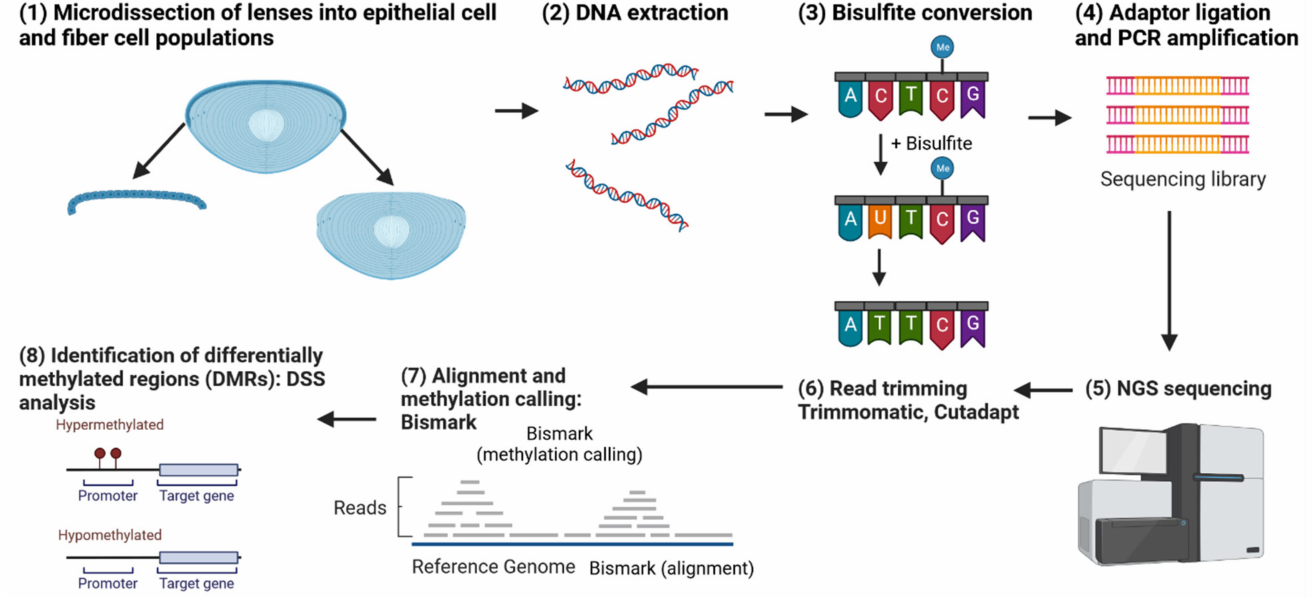
Figure 11. Workflow for a whole-genome bisulfite sequencing (WGBS) experiment comparing lens epithelial cells and fiber cells. The figure outlines the steps from sample preparation, bisulfite conversion, and sequencing to data preprocessing and analysis. The WGBS data are used to identify differentially methylated regions (DMRs) between lens epithelial and fiber cells, providing insights into the role of DNA methylation in lens differentiation. Additionally, the figure highlights the incorporation of transcription factor consensus sequence analysis to uncover potential regulatory the epigenetic mechanisms governing lens cell differentiation. Created with BioRender.com